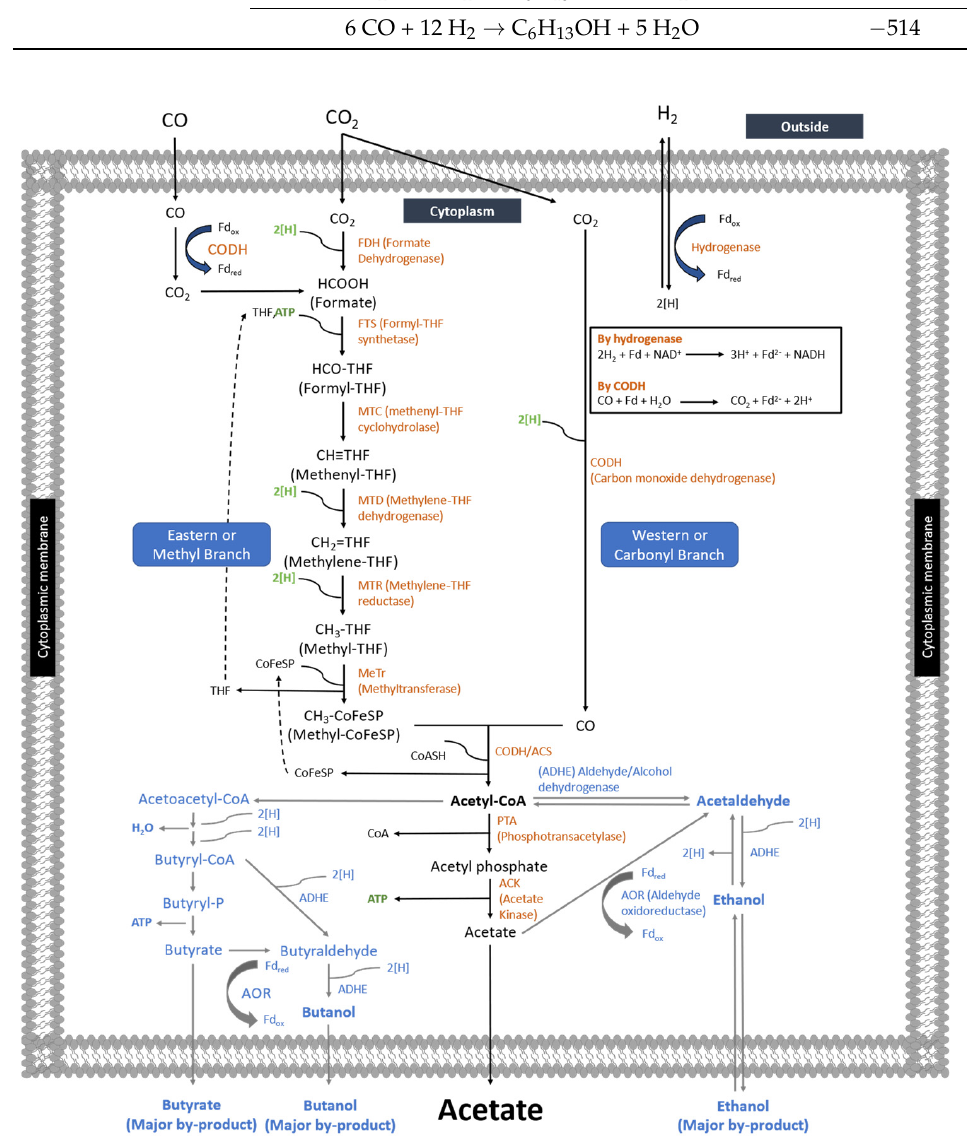
Figure 2. Wood–Ljungdahl Pathway of C. carboxidivorans using C1 gases (CO and CO 2 ) [49]. A batch fermentation test of C. carboxidivorans using 2.2 atm CO gas maximally